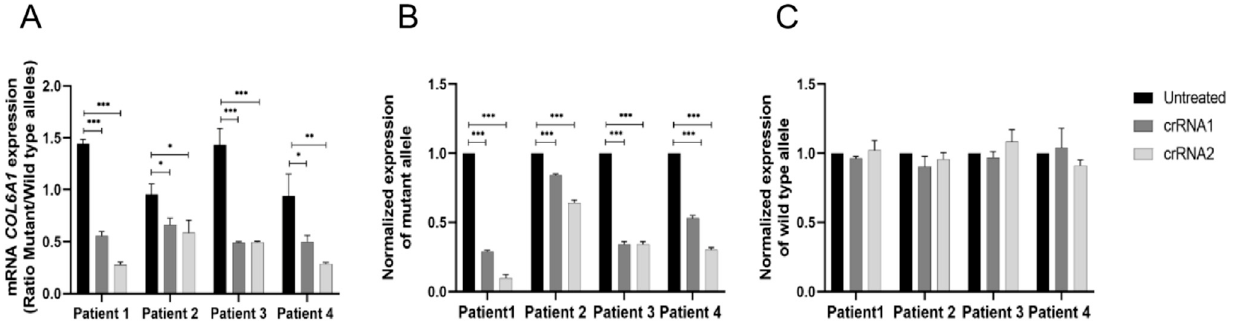
Figure 3. Transcriptional silencing of the mutant allele in patient-derived fibroblasts. Measurement of mRNA levels of the mutant and wild-type alleles of COL6A1 by allele-specific digital-droplet PCR in individuals’ fibroblasts. ( A ) Ratio of the expression of mutant versus wild-type alleles in fibroblasts untreated or edited with crRNA1 or crRNA2. ( B ) Normalized expression of the mutant allele in the edited fibroblasts. ( C ) Normalized expression of the wild-type allele in the edited fibroblasts. Data are presented as mean ± SD ( n = 3). Student’s t test was used to compare the data (* p < 0.05; ** p < 0.01; *** p < 0.001).